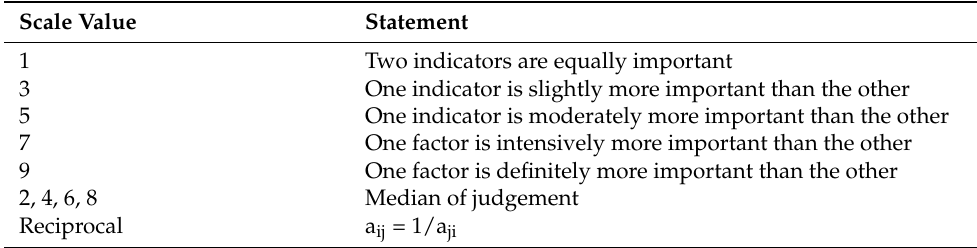
Table A1. Scaling method of the judgement